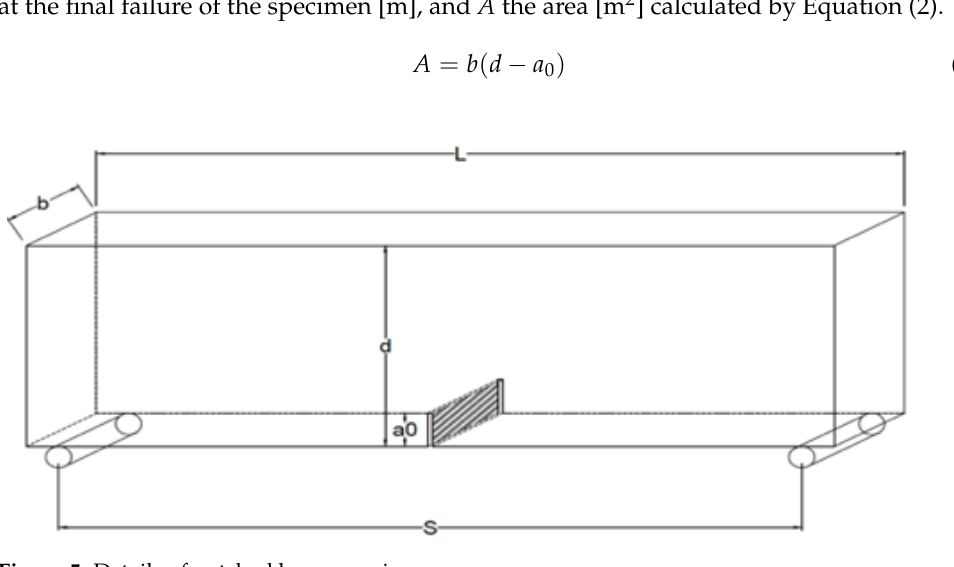
Figure 5. Details of notched beam specimen.